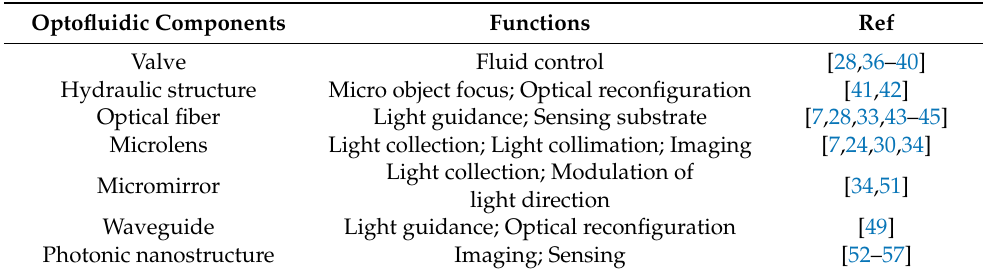
Table 2. Key components in optofluidic